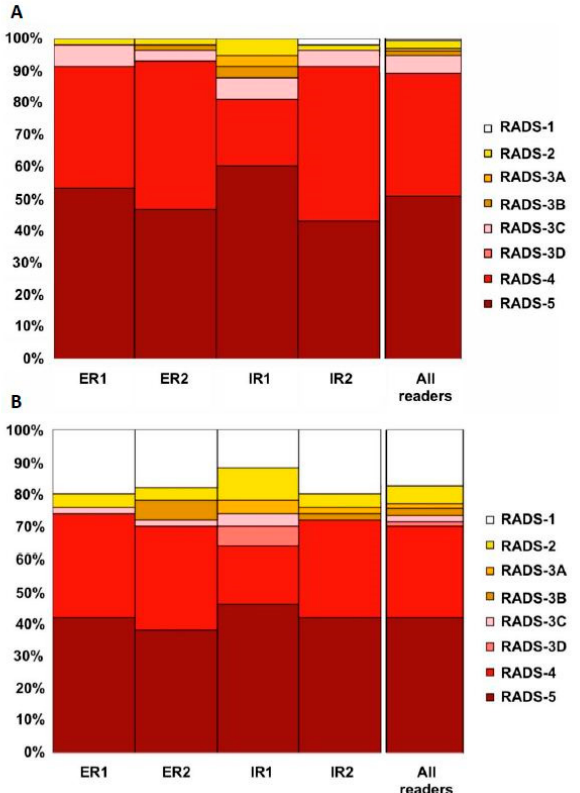
Figure 10. ( A ) Overview of target lesion (TL) assessment (identical target lesion included by all four readers on 50 PSMA-positron emission tomography (PET)/computed tomography (CT) scans with 18 F-DCFPyL). The following organ compartments were defined: lymph nodes (LN), skeleton,